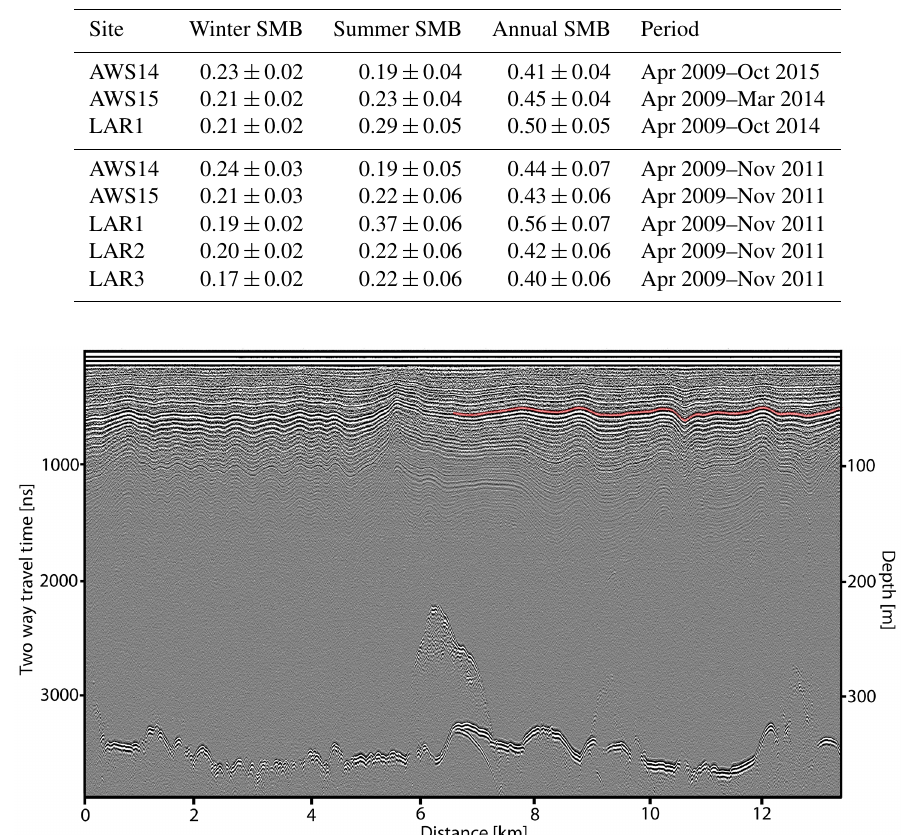
Table 2. Estimates of mean winter (April–October), summer (November–March) and annual SMB (in mw.e.year − 1 ) for five sites with continuous sonic height ranger observations. The rightmost column shows the period on which the estimated SMB is based. The bottom five rows show results for the longest common period of all records (April 2009–November 2011). The confidence interval reflects the measurement accuracy, not the interannual variability. Winter and annual SMB are derived from sonic height ranger and density observations; summer SMB is derived as the difference between them.